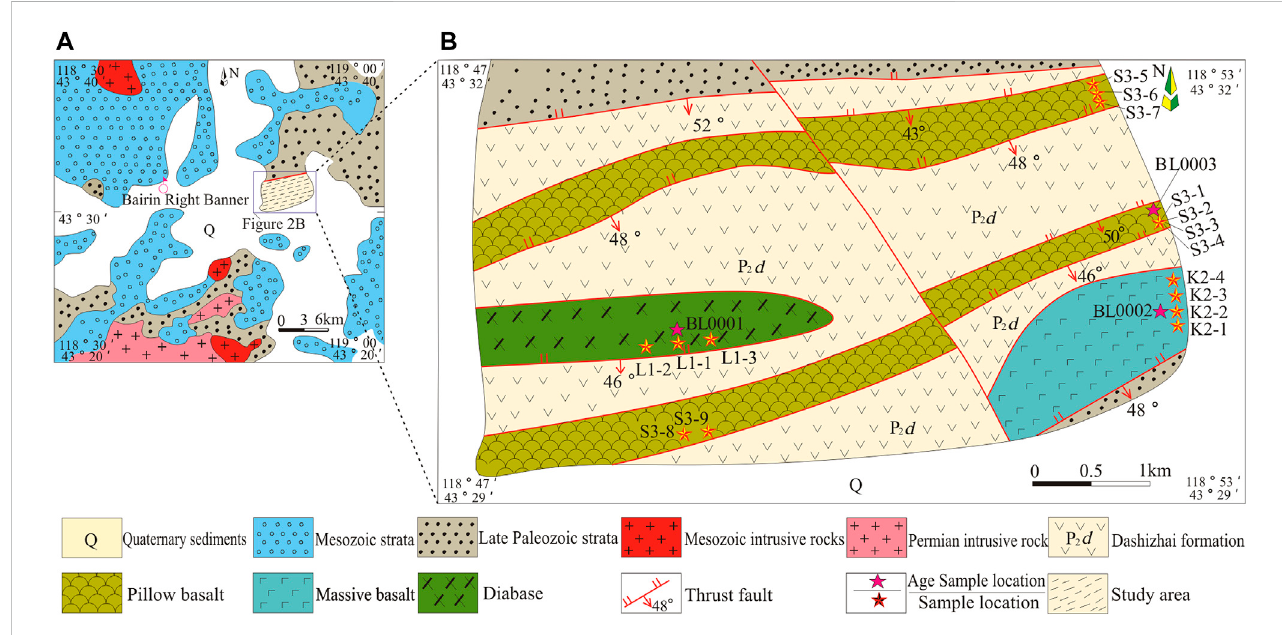
FIGURE 2 (A) Location of the study area. (B) Geological map in Bairin Right Banner, Inner Mongolia.